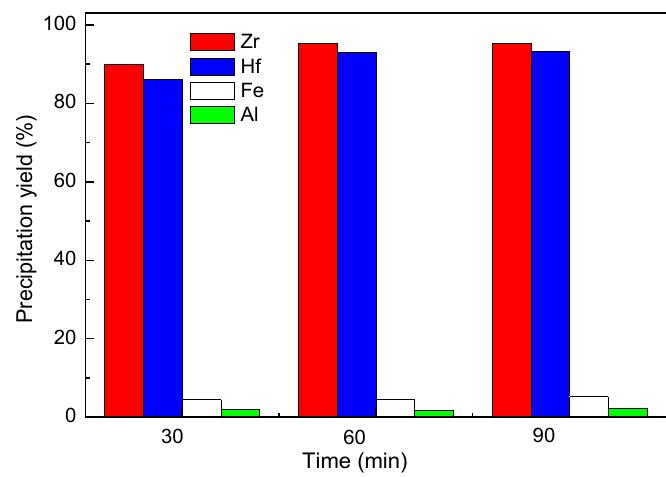
Figure 9. Effect of time on Zr precipitation yield, Zr precipitation conditions: final pH ~1.6, 75 °C, C(SO 42‒ ) = 12.4 g/L.